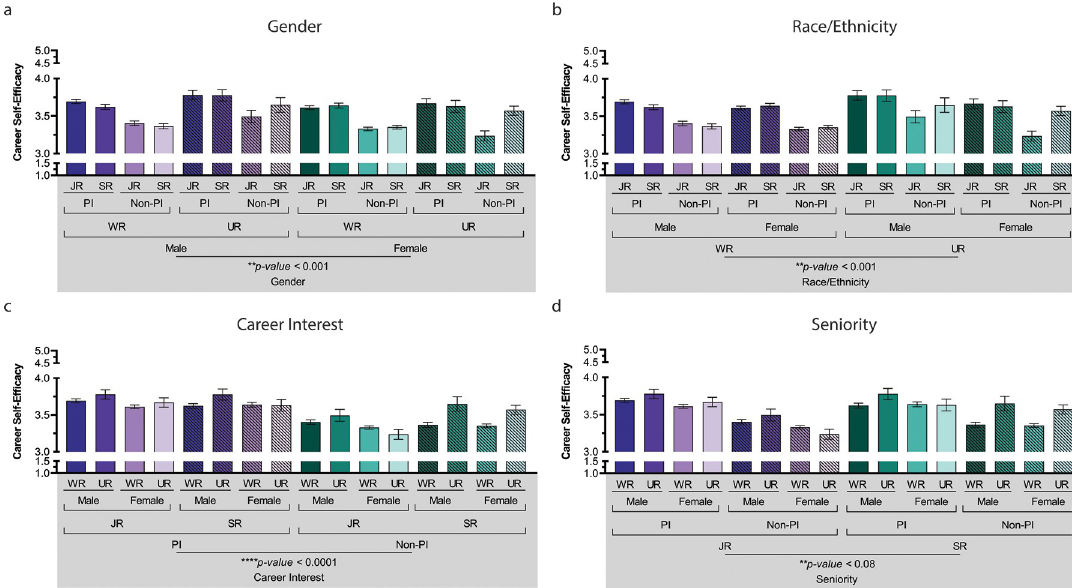
Fig 1. Main effects of gender, race/ethnicity, career interest, and seniority. Legend. Main effects of gender, race/ethnicity, career interest, and seniority. All main variables showed a significant effect on self-career efficacy, with the exception of seniority, which was trending but not significant. A four-way ANOVA of gender, race/ethnicity, career interest, and seniority on the level of CSE showed significant main effects for each variable. P-values indicate the main effects for each variable of interest, ���� p < 0.0001, �� p < 0.01, and � p < 0.05. (WR = Well-Represented, UR = Underrepresented, JR = Junior, SR = Senior). Color differences (green and purple) indicate main effect for each variable. For 1a gender (male vs. female), 1b race/ethnicity (WR vs. UR), 1c career interest (PI vs non-PI), and 1d seniority (JR vs.